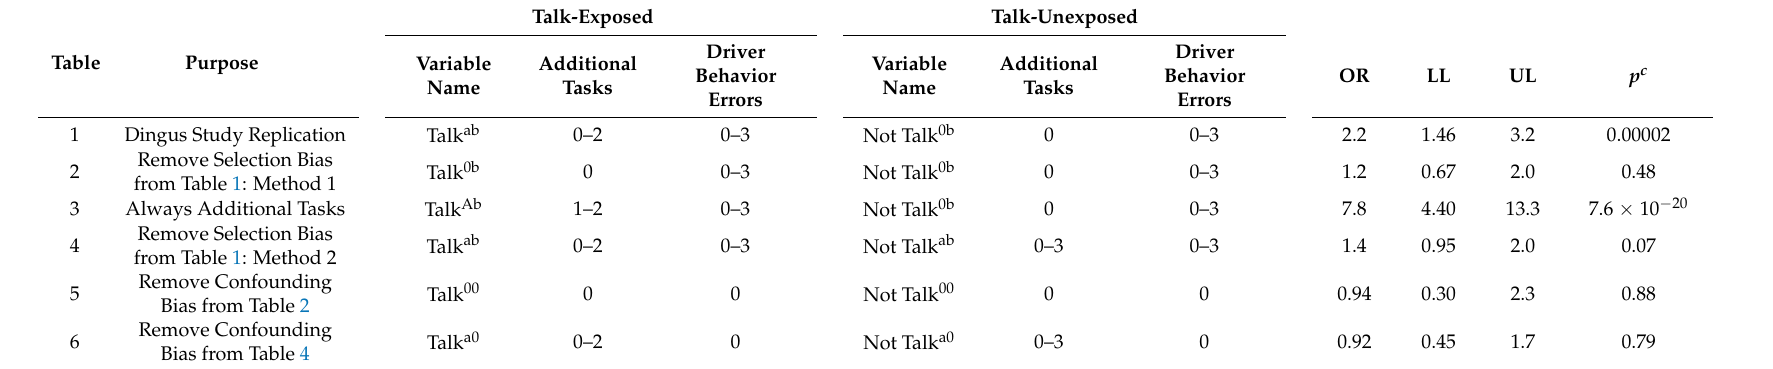
Table 7. Overall study design and OR estimate